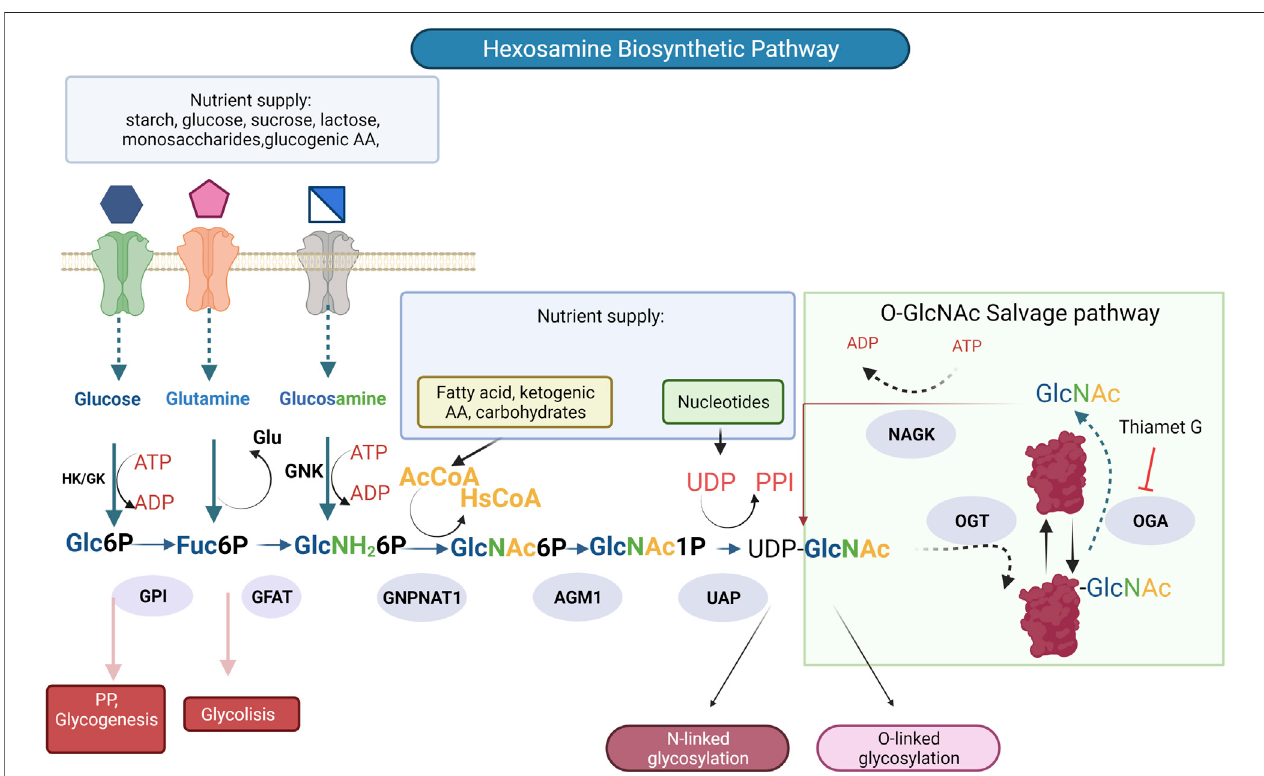
FIGURE 3 | The hexosamine biosynthetic pathway (HBP) is responsible for the production of UDP-N-acetylglucosamine (UDP-GlcNAc), the substrate for protein glycosylation. Glucose is phosphorylated by hexokinase (HK) producing glucose-6-phosphate, which is converted into fructose-6-phosphate by phosphoglucose isomerase (GPI). At this point (F6P) can come into the HBP or continue through glycolysis to produce pyruvate. In the rate limiting step of the HBP (GFPT1/GFAT) -glutamine-fructose-aminotransferase catalyzes the conversion of fructose-6-phosphate and the amino group donor, glutamine to glucosamine-6-phosphate (GlcN-6P) and glutamate (Glu). The subsequent reaction is catalyzed by glucosamine-6-phosphate N-acetyltransferase (GNPNAT1) transform glucosamine-6- phosphate and acetyl-coenzyme A (Ac-CoA) to N-acetylglucosamine-1-phosphate (GlcNAc-1P) and CoA. Then, the phosphoglucomutase 3 (PGM3/AGM1) converts (GlcNAc-6P) to N-acetylglucosamine-1-phosphate (GlcNAc-1P). The following enzymatic reaction UDP-N-acetylglucosamine pyrophosphorylase 1(UAP1) utilizes GlcNAc-1PandUTPforthesynthesisofuridinediphosphate N- acetylglucosamine(UDP-GlcNAc),Enzymesareinvolved(blueovals),ThiametGisaninhibitorofenzyme